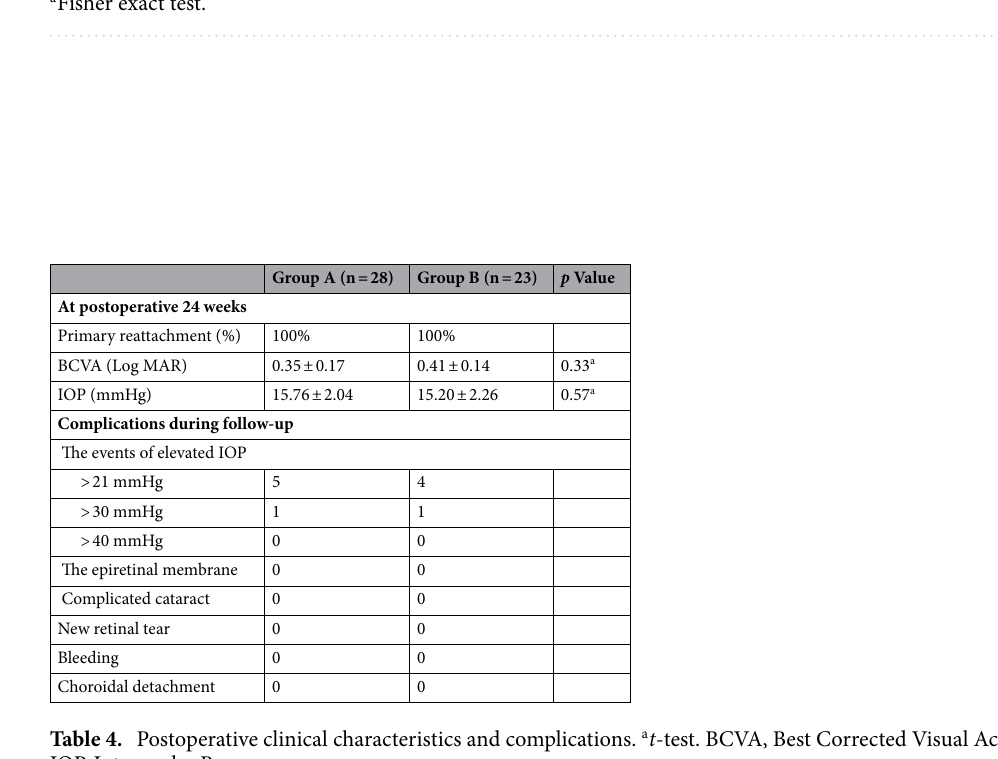
Table 3. Comparison of persistent SRF at postoperative 24 weeks in patients with different location of breaks. a Fisher exact test.